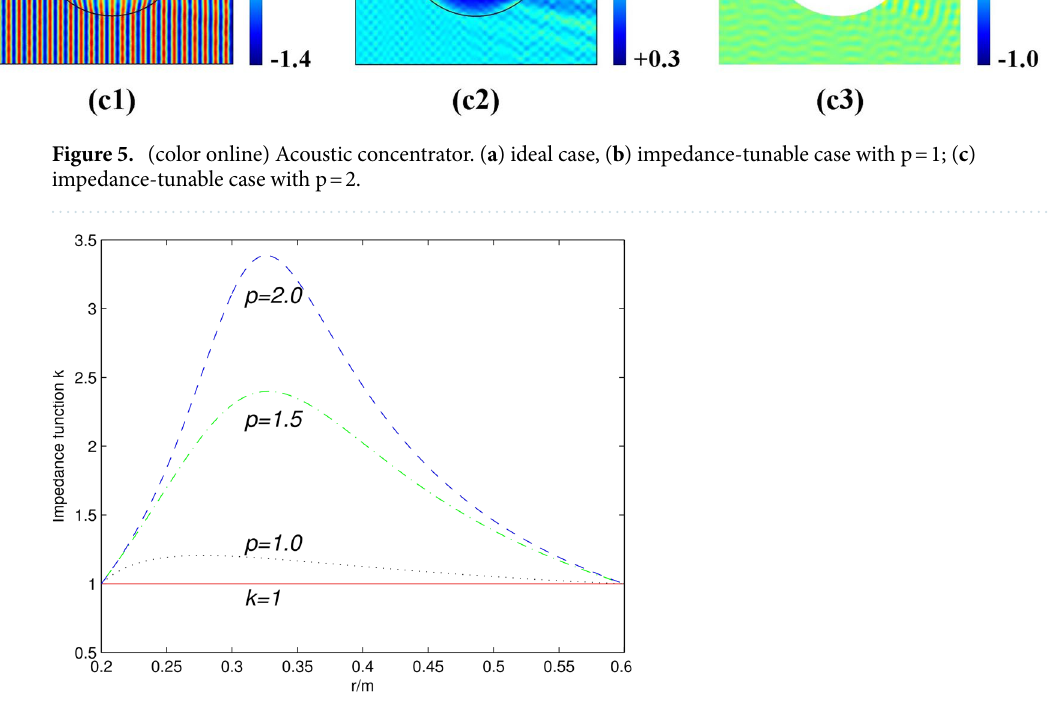
Figure 6. (color online) Impedance functions value distribution in the radial direction for the original space of the concentrator. The solid red line corresponds to the ideal design case with the constant k = 1. The dotted purple, dash-dotted green and dashed blue lines correspond to the impedance-tunable design case with constants p = 1, p = 1.5, and p = 2,